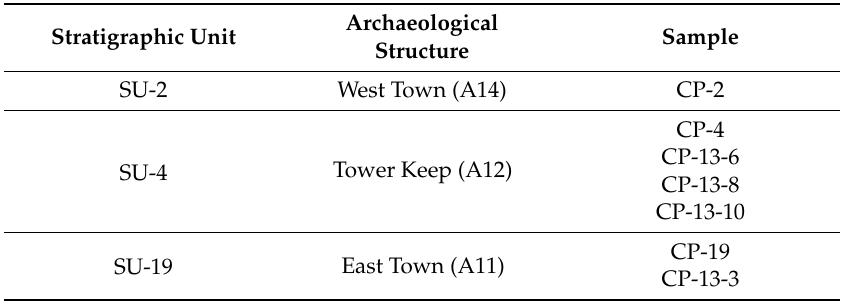
Table 1. Studied samples from different structures at Portilla